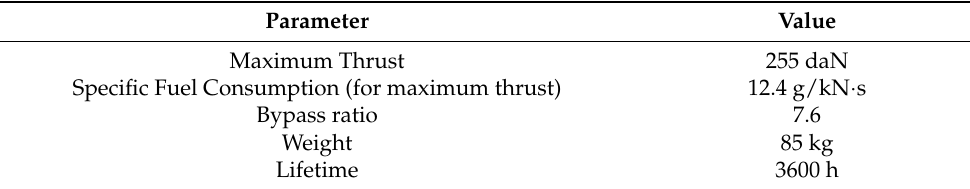
Table 2. Technical specification of the DGEN 380 turbofan [36].